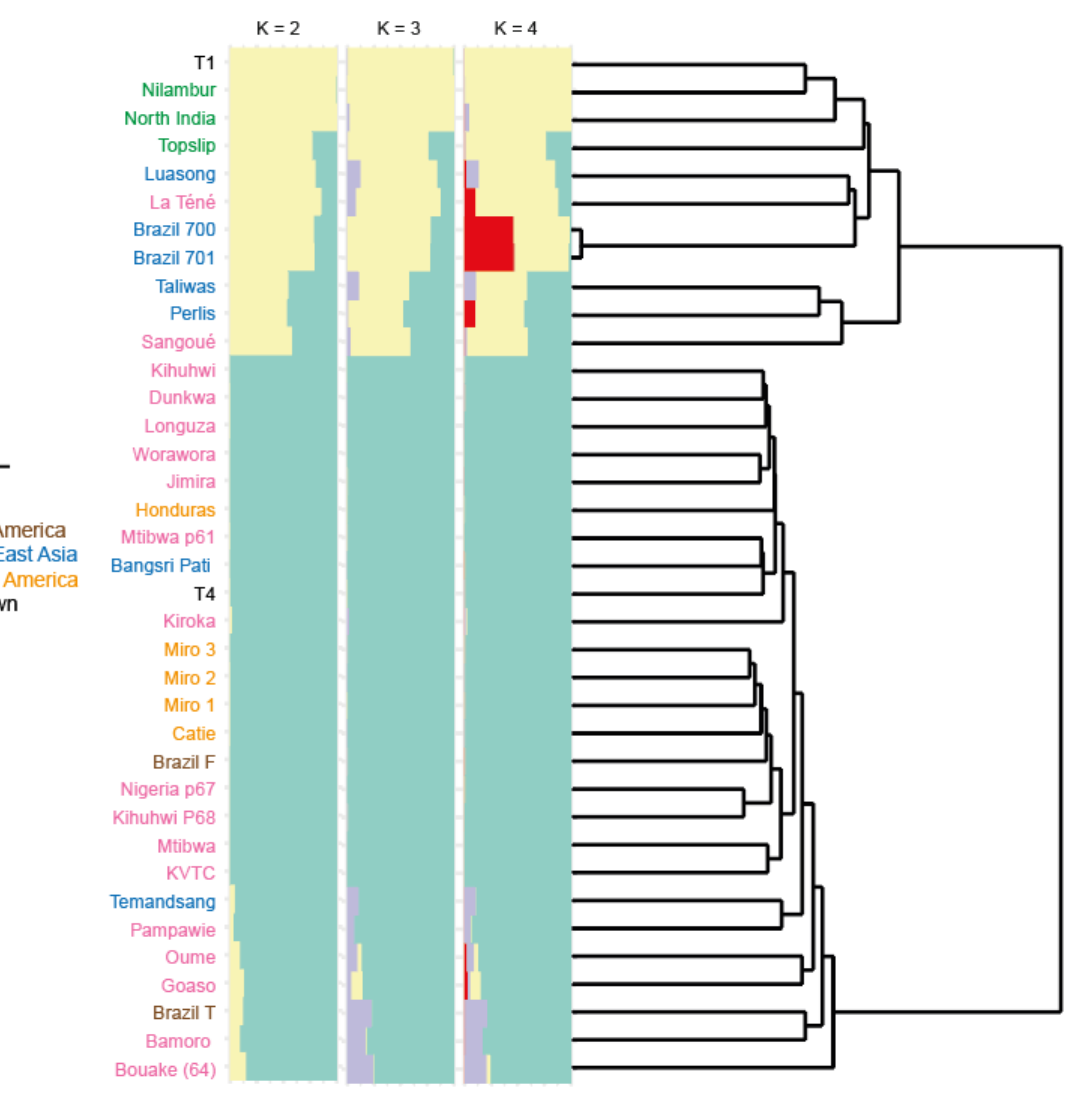
Figure 2. Clustering of teak stands of different provenances. Shown is a dendrogram based on genetic distance (right part) and the different clusters as identified by the structure analysis (green, cluster 1; yellow, cluster 2; pink, cluster 3 and red, cluster 4). The dendrogram was generated by hierarchical clustering (UPGMA) based on genetic dissimilarity. Vertical lines in the dendrogram give the amount of genetic dissimilarity and represent genetic lineages. Each row represents an individual tree per provenance, with the length of the different colour segments representing the proportion of a cluster in an individual’s genetic makeup. K=2–4 indicates the number of genetic clusters that were revealed in this structure analysis from 2 to 4. The most likely number of clusters was